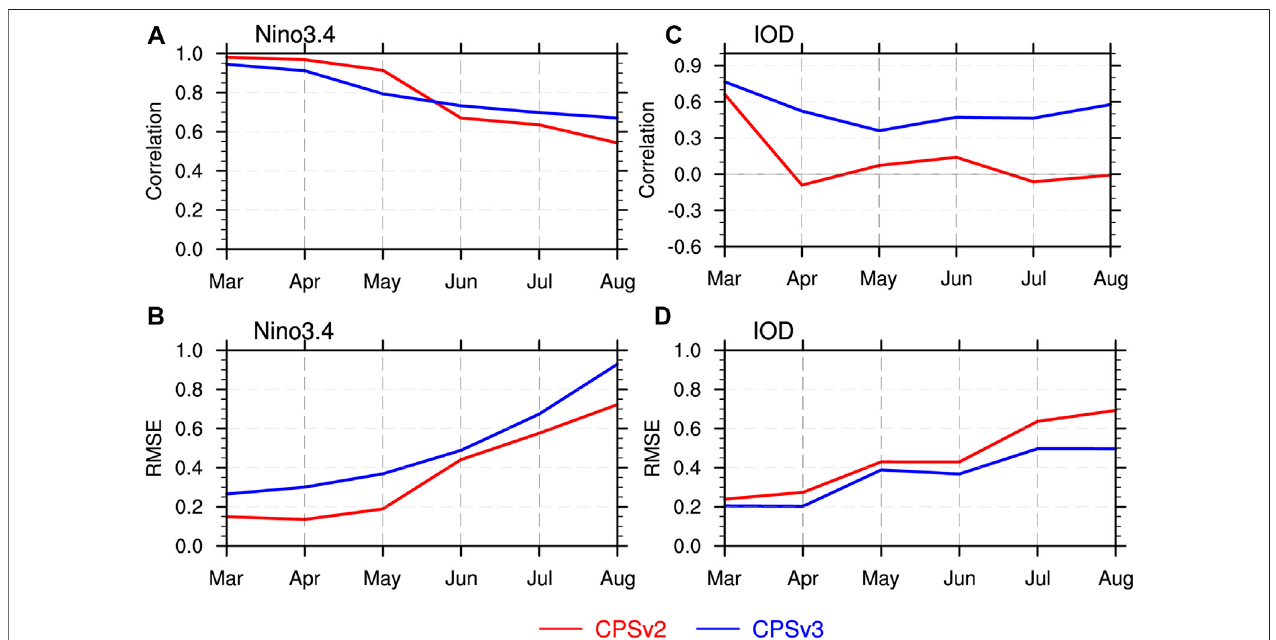
FIGURE 9 | TCC and RMSE of Nino3.4 and IOD indices. (A,B) Nino3.4 index and (C,D) IOD index